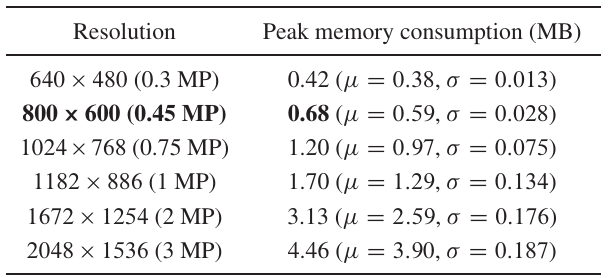
Table 4. Memory consumption of the present technique for various